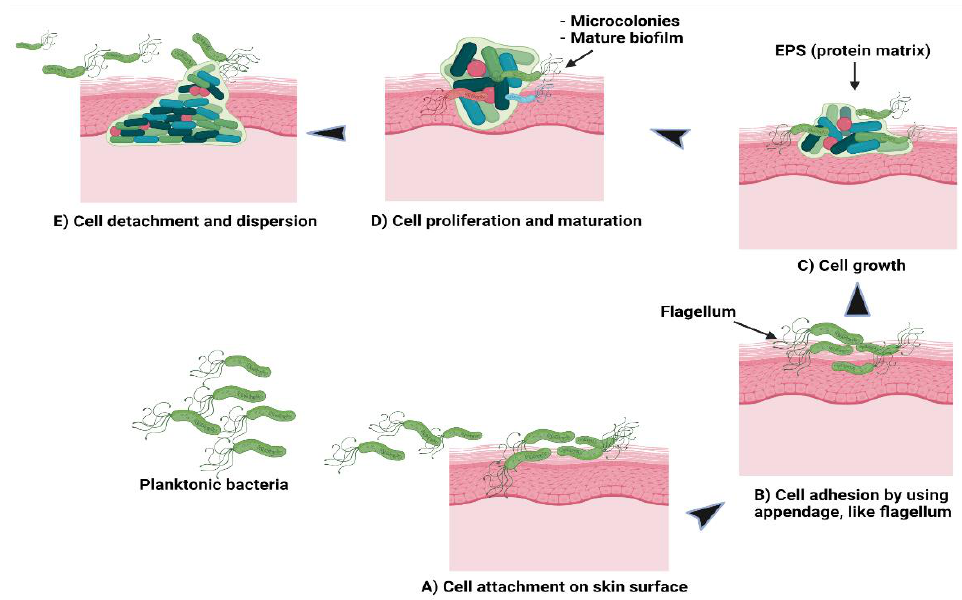
Figure 2. Schematic of ( A ) bacterial cell attachment to the skin’s surface; ( B ) irreversible cell at- tachment through appendages; ( C ) cells’ growth and EPS synthesis; ( D ) cells’ proliferation and maturation to form microcolonies and biofilms; ( E ) cells’ detachment from biofilms to disperse contents as planktonic cells to form new biofilms.